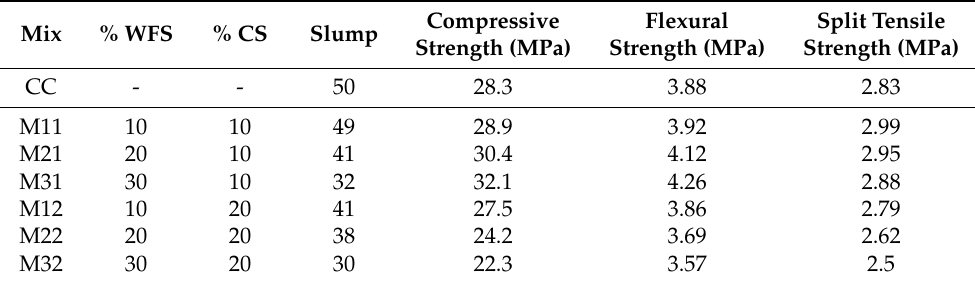
Table 1. Strength properties of WFS-WCS